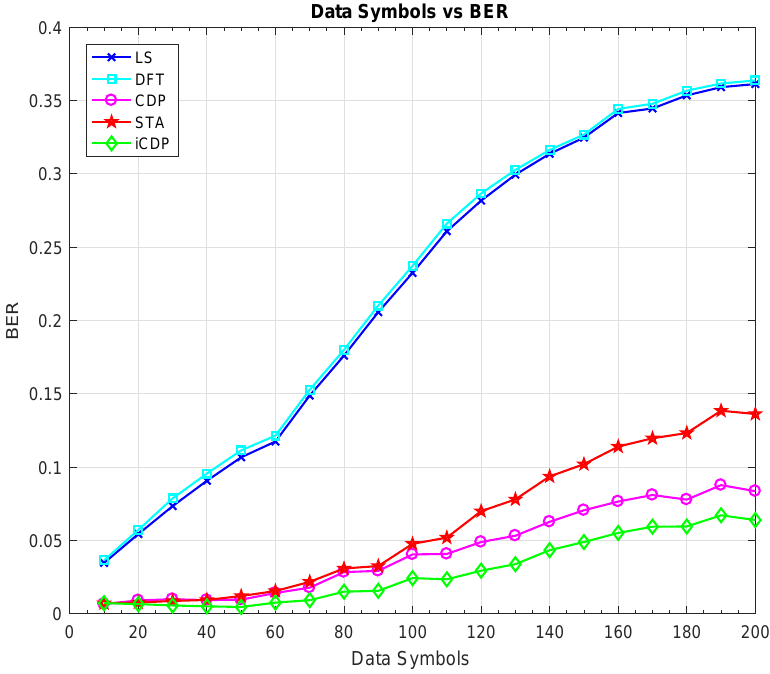
Figure 6. Bit Error Rate (BER) vs. length of data symbols for HIgh PERformance radio Local Area Network (HIPERLAN-E) Channel and f d = 1200 Hz.